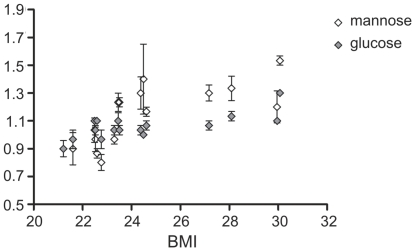
Average concentrations of two soluble sugars, glucose and mannose, are significantly increased in plasma samples of healthy volunteers with higher BMI values.pGlucose = 0.0014, pmannose = 0.0001. Error bars represent standard error within monthly measurements.